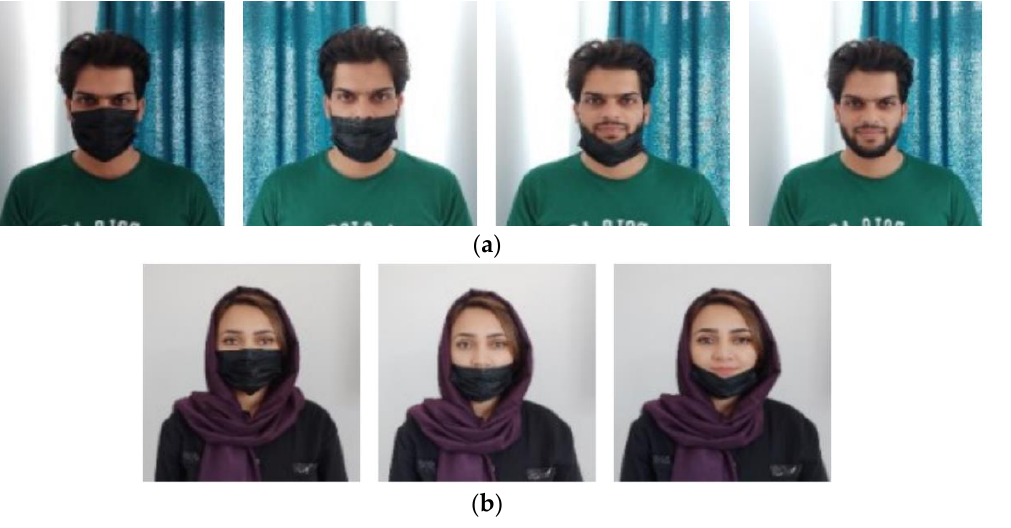
Figure 2. Samples of facial images of individuals wearing masks in: ( a ) 4 different ways/styles (wear- ing the mask fully, half, partially, or not wearing one at all); ( b ) 3 different ways/styles (wearing the mask fully, half, or partially). Table 1. Face mask image dataset training and testing split. Table 1. Face mask image dataset training and testing